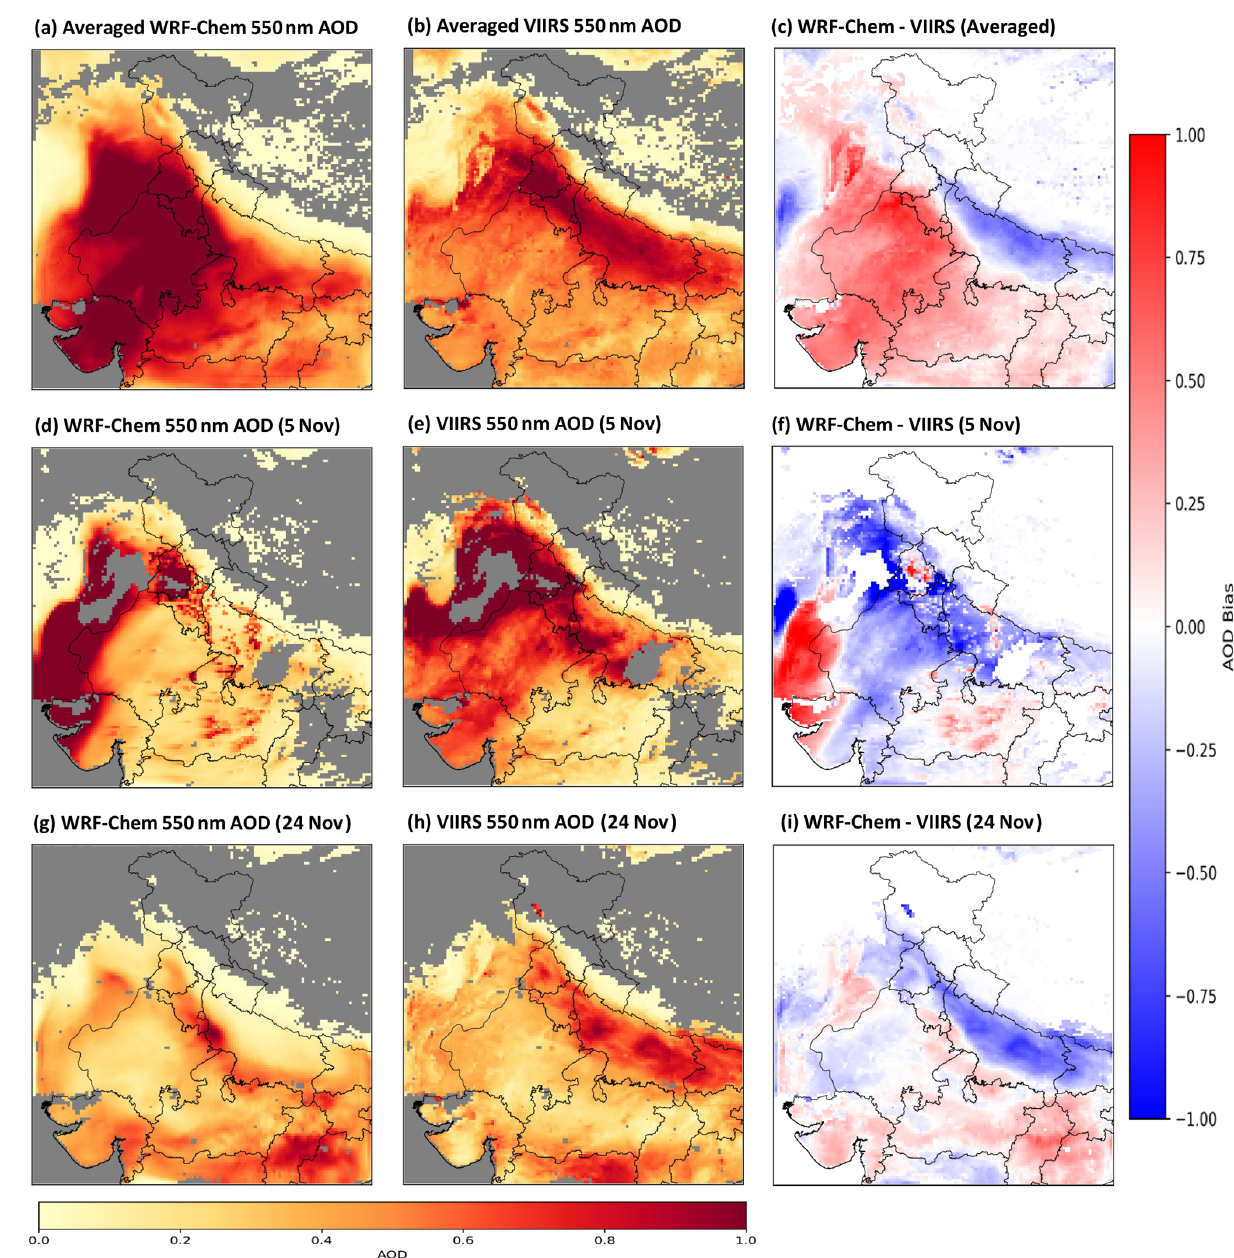
Figure 3. Spatial distributions of AOD at 550nm averaged over the whole of November (a–c) , 5 November (d–f) , and 24 November (g–i) . WRF-Chem maps represent base scenario results. Differences between model and VIIRS are also